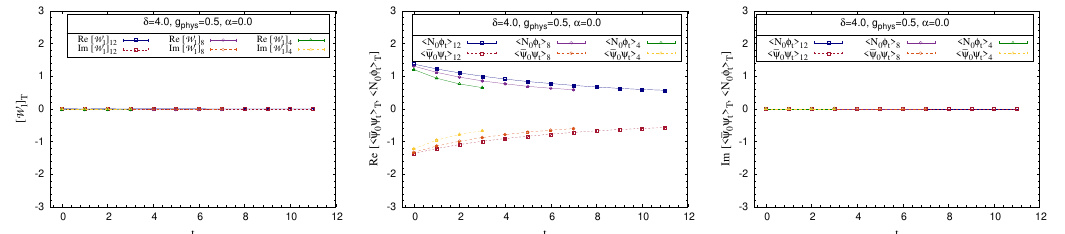
Figure 8 . The PT -symmetric model with δ = 4 . The full Ward identity (left) and real (middle) and imaginary (right) parts of bosonic and fermionic contributions to Ward identity, for lattices with T = 4 , 8 , and 12